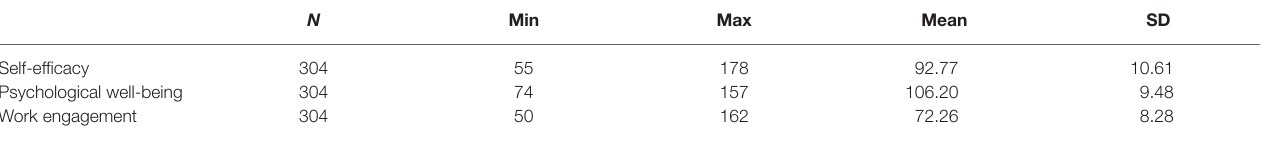
TABLE 2 | Descriptive statistics of the main variables.